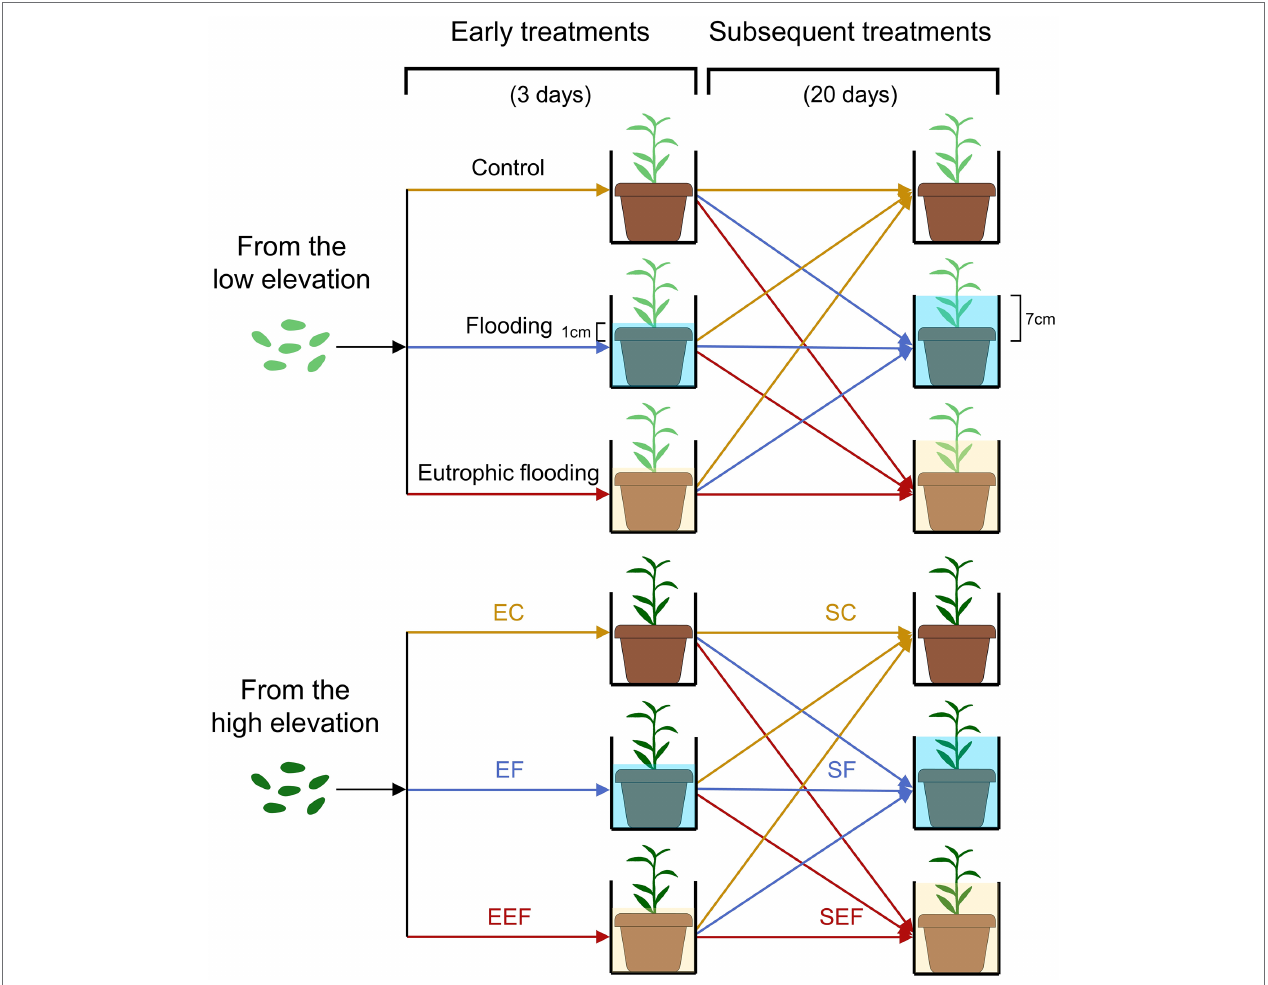
FIGURE 1 | Schematic representation of the experimental design. Seeds of Polygonum hydropiper were collected from three populations each at low and high elevations in the Three Gorges Reservoir (TGR) region. Early treatments include early control (no flooding, EC), early flooding (using a floodwater depth of 1 cm above the soil surface, EF), and early eutrophic flooding treatments (using a eutrophic floodwater depth of 1 cm above the soil surface, EEF). After early treatments, plants were subjected to three subsequent flooding treatments: control (no flooding, SC), flooding (using a floodwater depth of 7 cm above the soil surface, SF), and eutrophic flooding (using a eutrophic floodwater depth of 7 cm above the soil surface, SEF). The N and P concentrations of eutrophic water were 2 and 0.15 mg L − 1 , respectively, which were set in reference to the eutrophication level of water in the